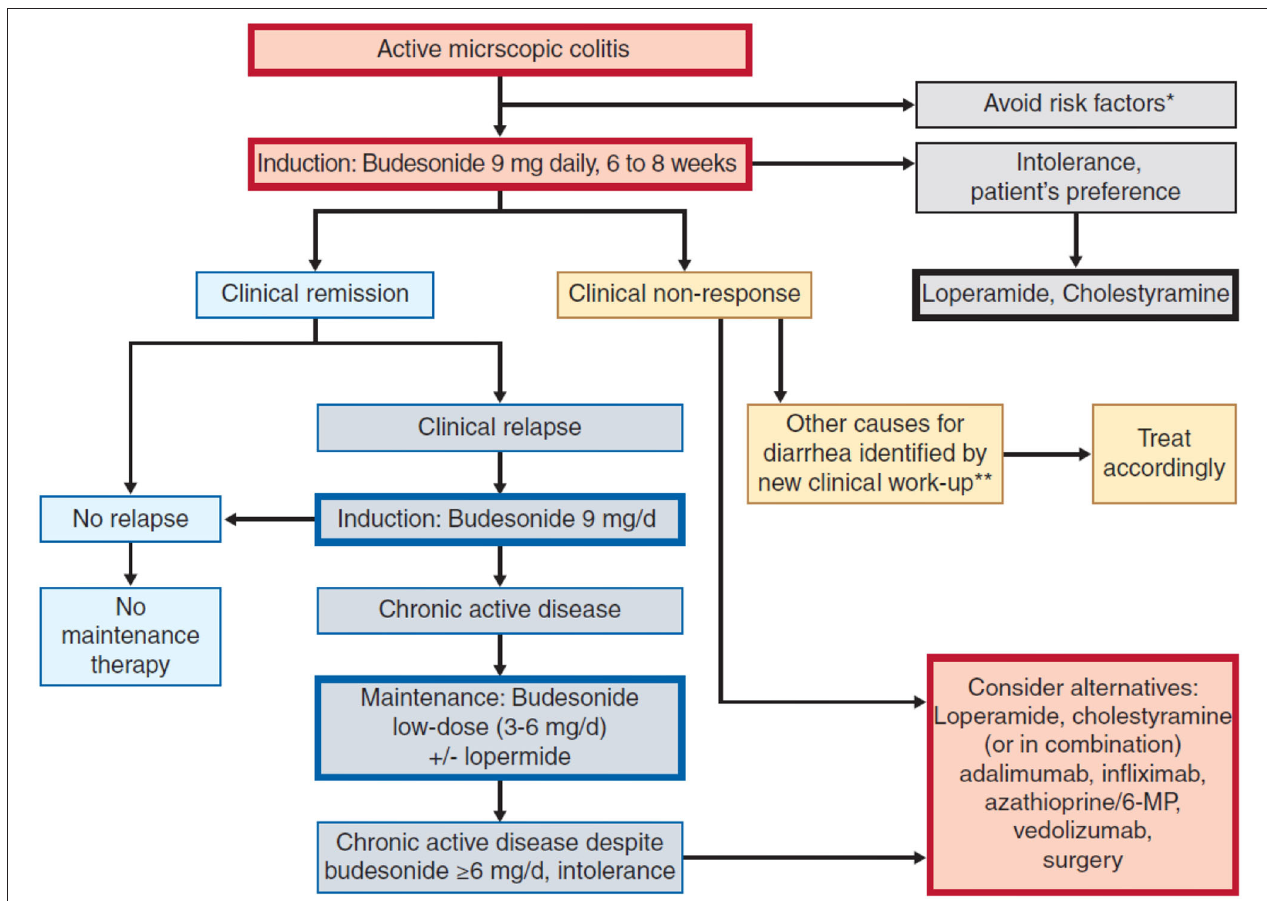
FIGURE 1 | Therapeutic algorithm for Microsopic Colitis- Miehlke et al. (64). *Smoking, NSAID, PPl, **i.e., bile acid diarrhoea, coeliac